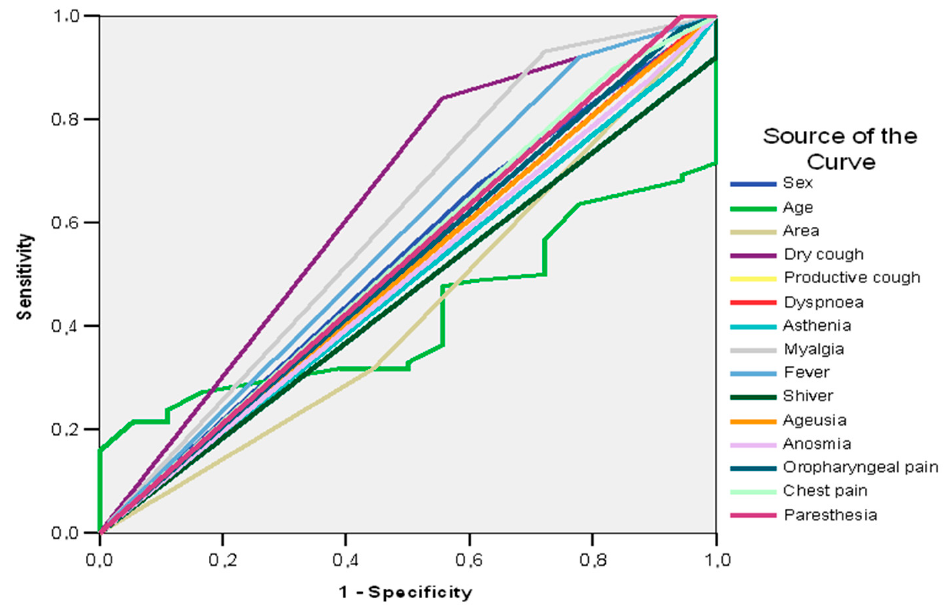
Figure 1. AUC. The sensitivity/specificity balance of signs and symptoms in the determination of pneumonia in patients with SARS-CoV-2.